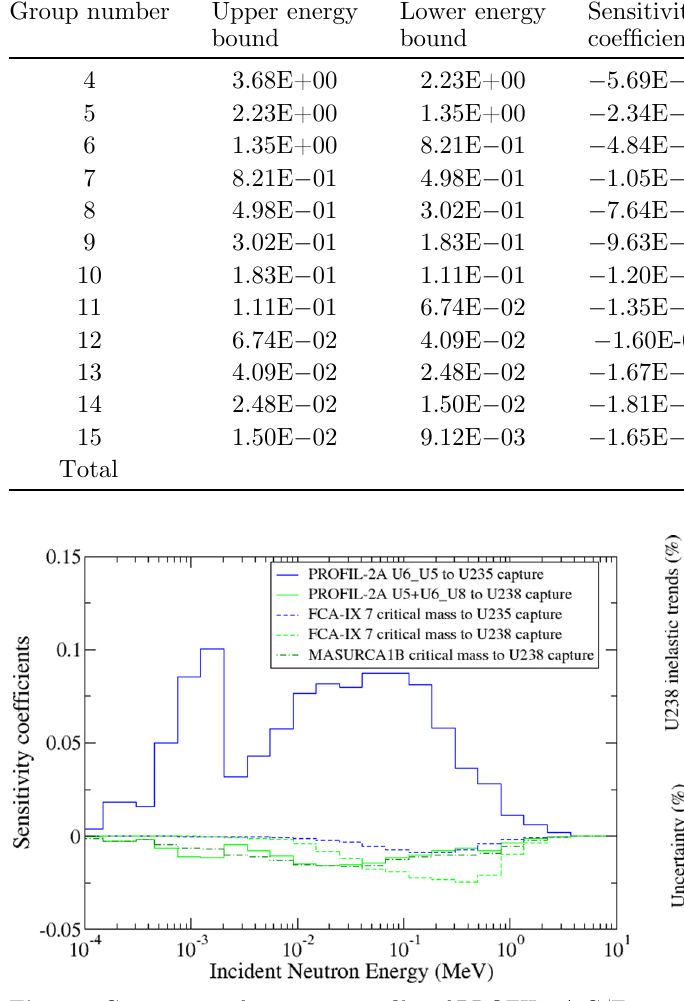
Fig. 12. Trends from assimilation work for 238 U inelastic (relative to JEFF-3.1.1) compared with a priori and a posteriori nuclear data uncertainties. For both cases ( fi ssion spectra fi tted or not), the two dotted lines have to be seen as an additional uncertainty associated to the choice of graphite